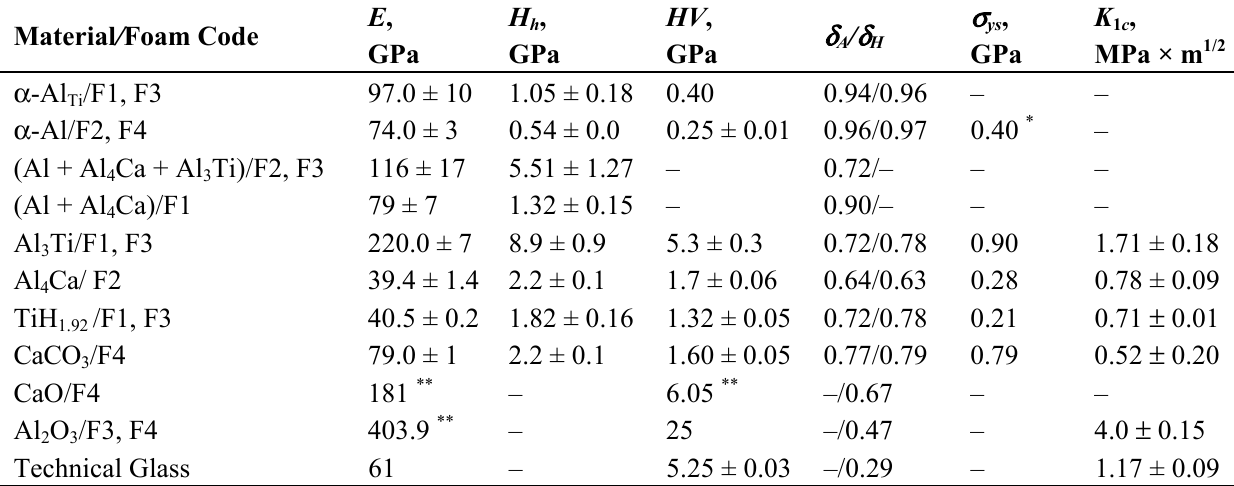
Ca and ( b ) Al Ti under indentation 4 3